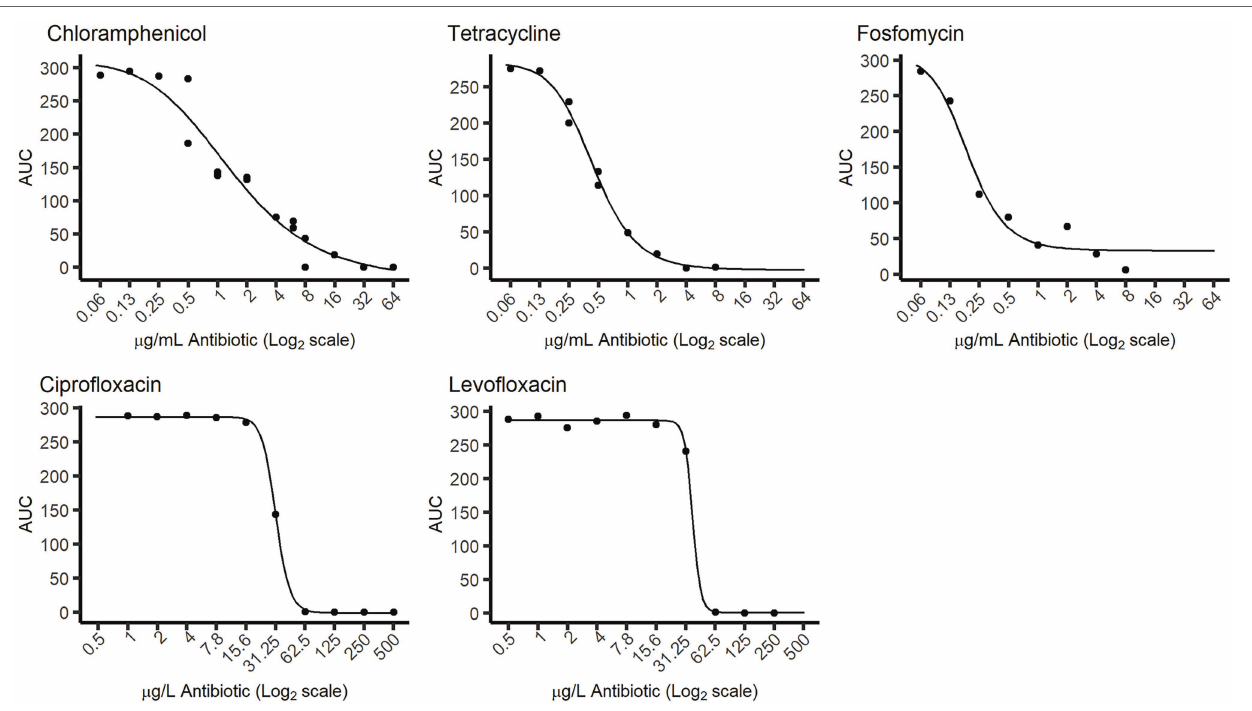
FIGURE 4 | Dose–response curves obtained from the “Sample run.” The response values (points in the graph) represent the AUC values of the growth curves after 46 h of incubation, calculated directly from the 1–6 classification levels. The curves were obtained by fitting those AUC values to the dose (antibiotic concentration) values using a Hill